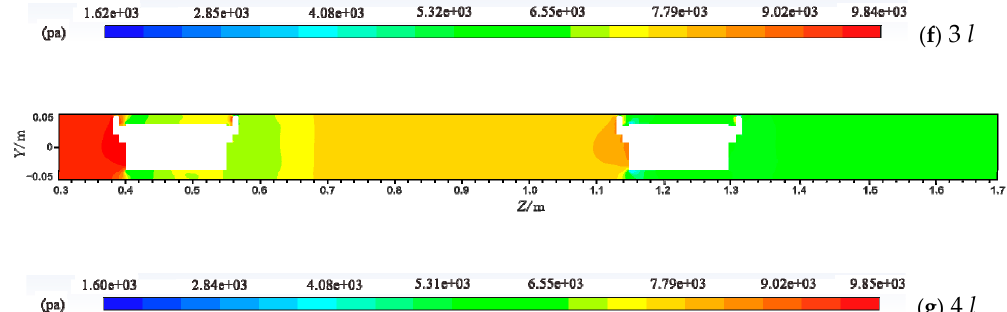
Figure 12. The pressure distribution cloud map of the YZ plane under different vehicle spacings. ( a ) L = 0.5 l . ( b ) L = l . ( c ) L = 1.5 l . ( d ) L = 2 l . ( e ) L = 2.5 l . ( f ) L = 3 l . ( g ) L = 4 l .